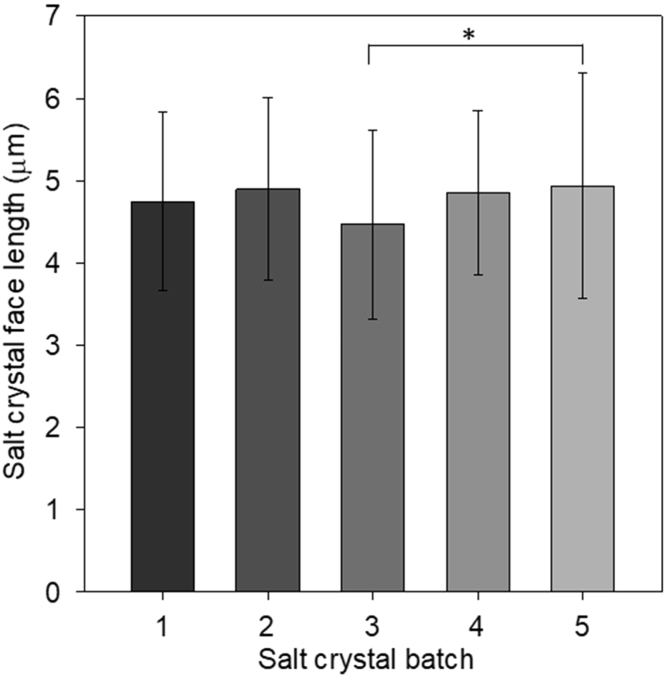
Size of microcrystalline sodium chloride produced in five separate batches. Data shown represents mean ± SD (n = 74–115). * indicates p < 0.05 for the indicated values.